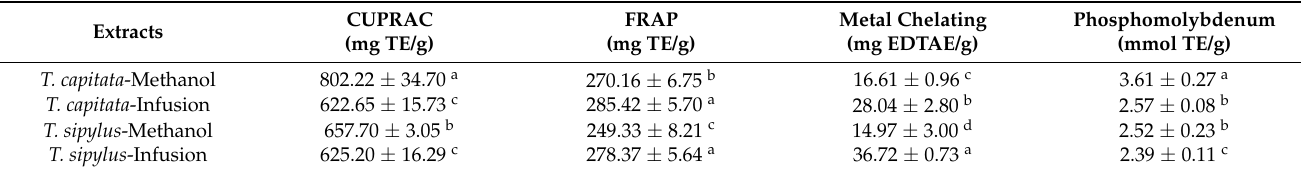
Table 5. Antioxidant properties of the tested extracts.